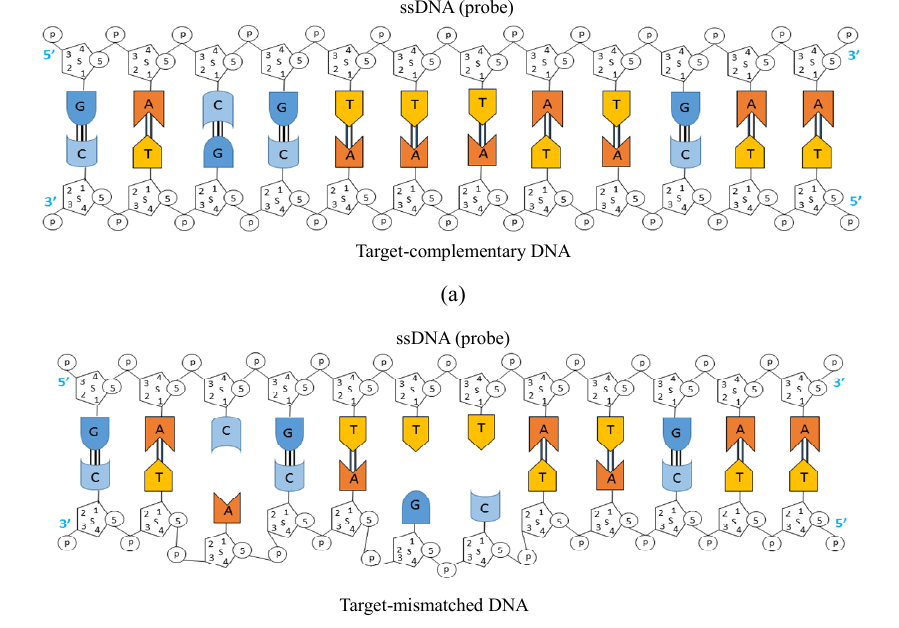
Fig. 3 Schematic of sequence orientation of adenine (A), thymine (T), guanine (G), and cytosine (C): (a) perfectly matched hybridization between shDNA and mrDNA sequences of BRCA2 gene (6174delT) and (b) mismatched hybridization between shDNA and wtDNA sequences. Here, A-T bond by di-hydrogen bonding, G-C bond by tri-hydrogen